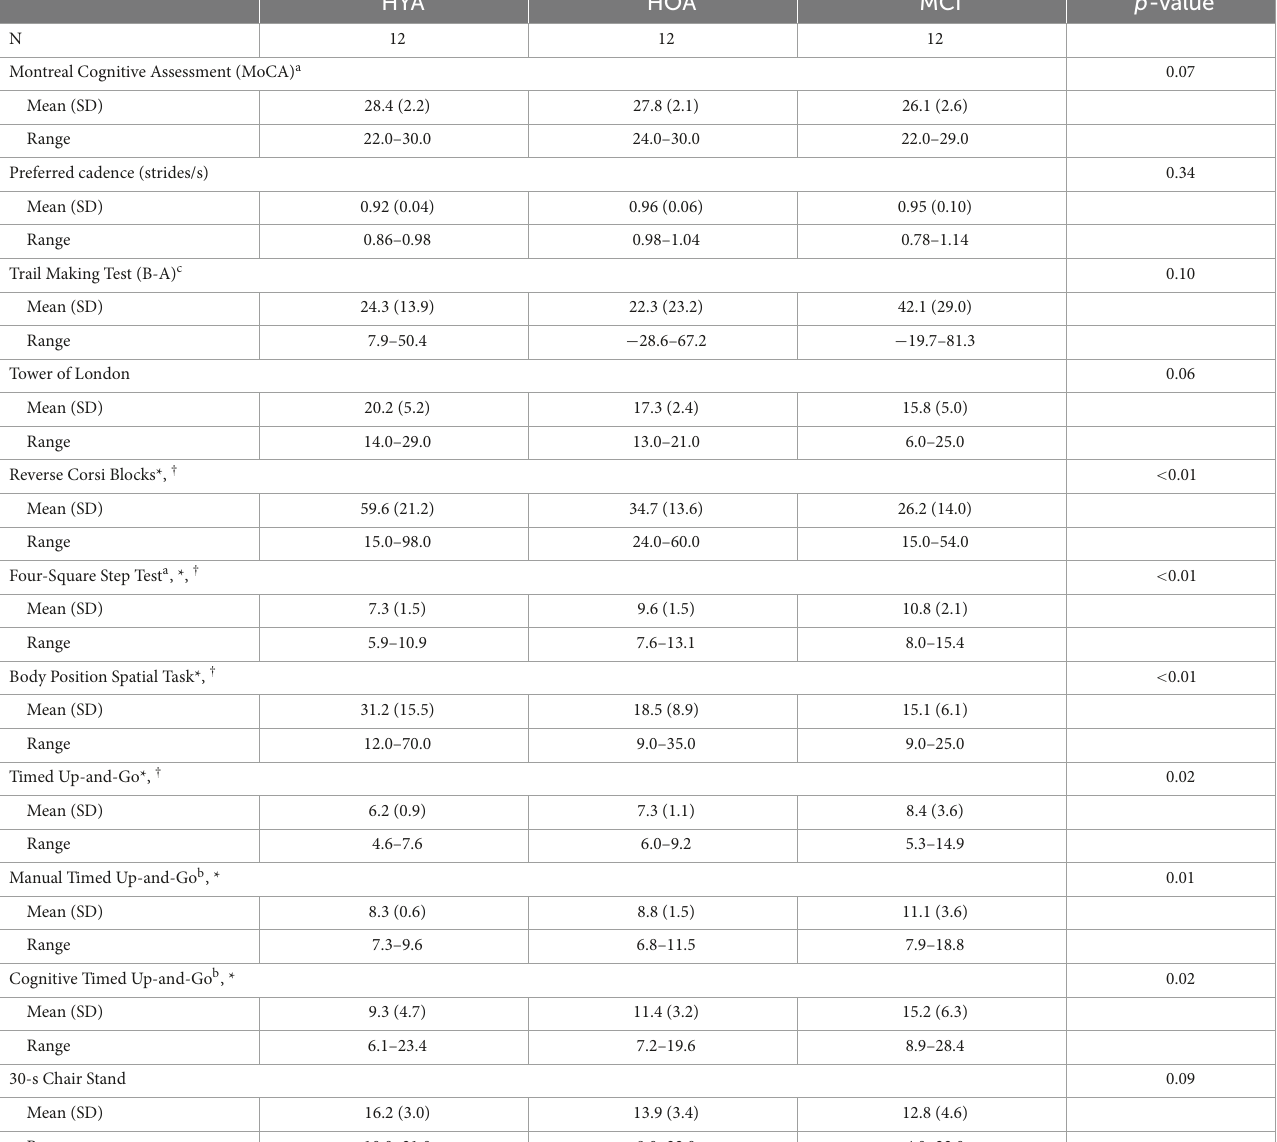
TABLE 2 Clinical characteristics of each participant